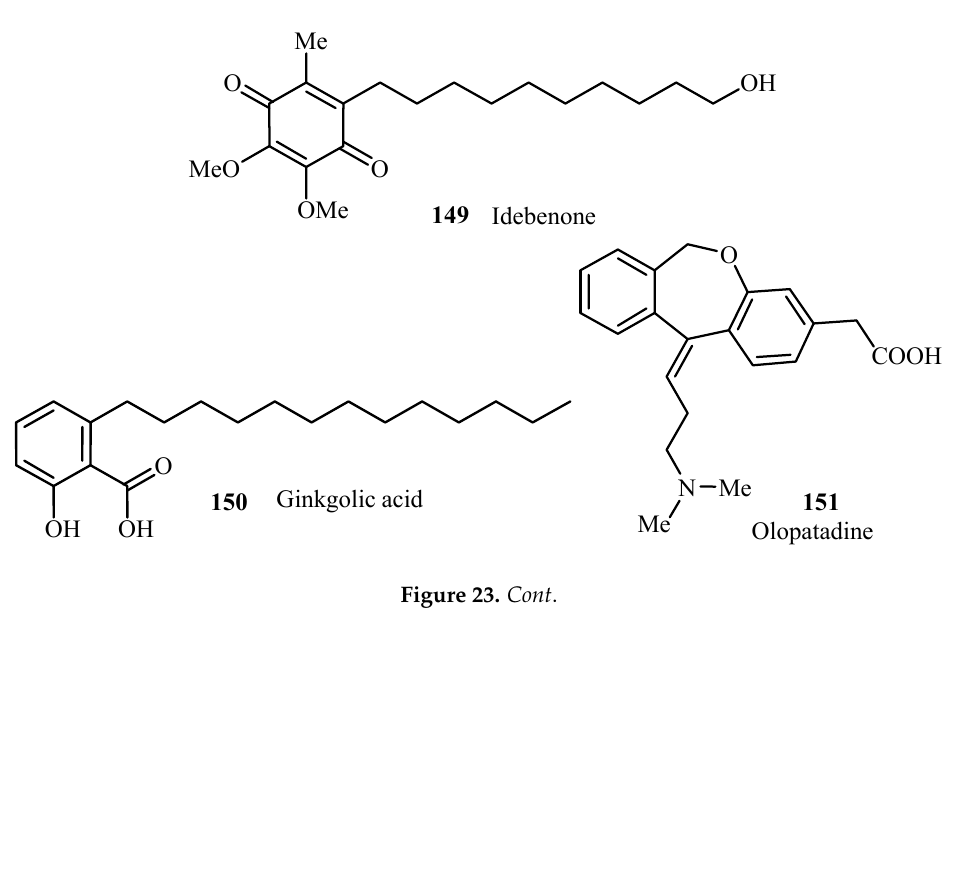
Figure 22. Cinnamic acid derivatives (CADs) reviewed by Sharma [83].